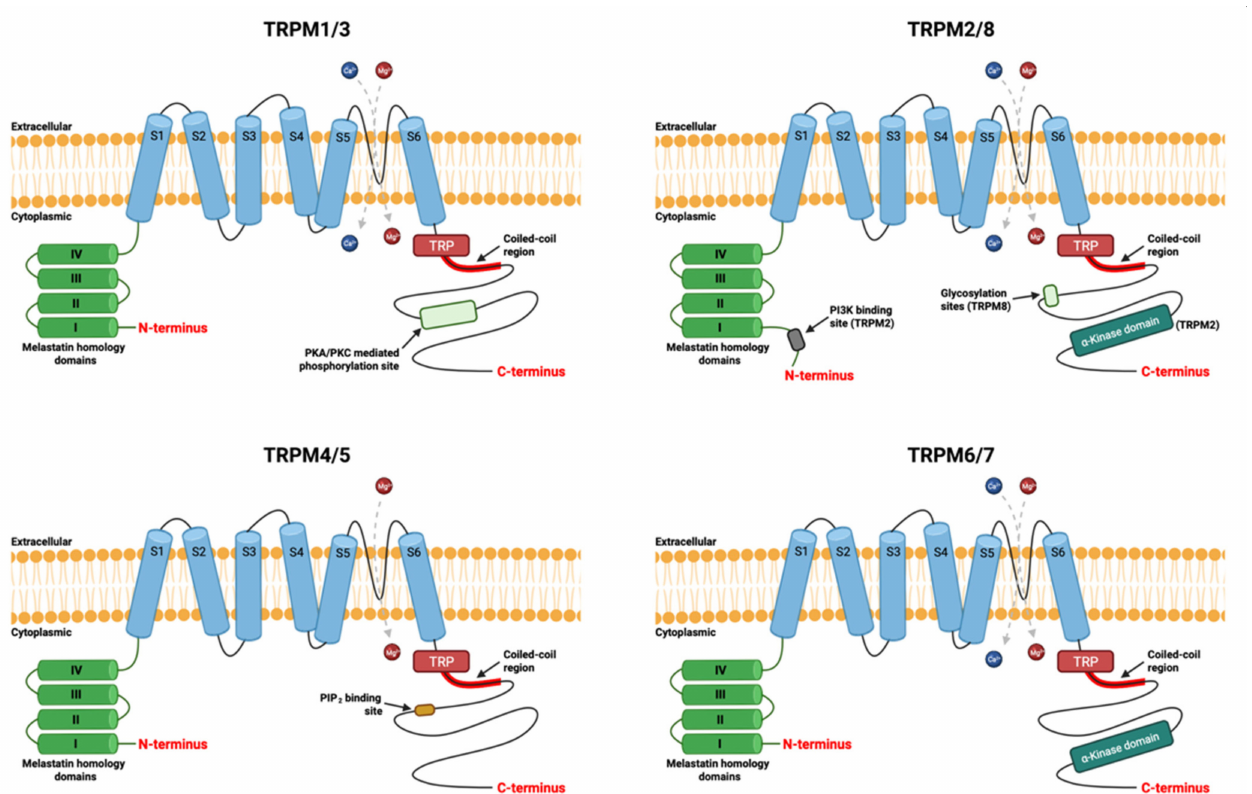
Figure 1. The general structure of subunits of the TRPM ion channel. Each subunits comprises six transmembrane segments (S1 to S6). The channel pore is located between the segments S5 and S6. It is permeable to divalent magnesium (Mg 2+ ) and calcium (Ca 2+ ) cations, except TRPM4/TRPM5. The amino-terminal (N-terminal) part has homologies’ domains of melastatin members. The carboxy-terminal (C-terminal) is the various part with a coiled-coil region involved in multimerization of the channels. Created using source BioRender.com source, accessed on 9 December